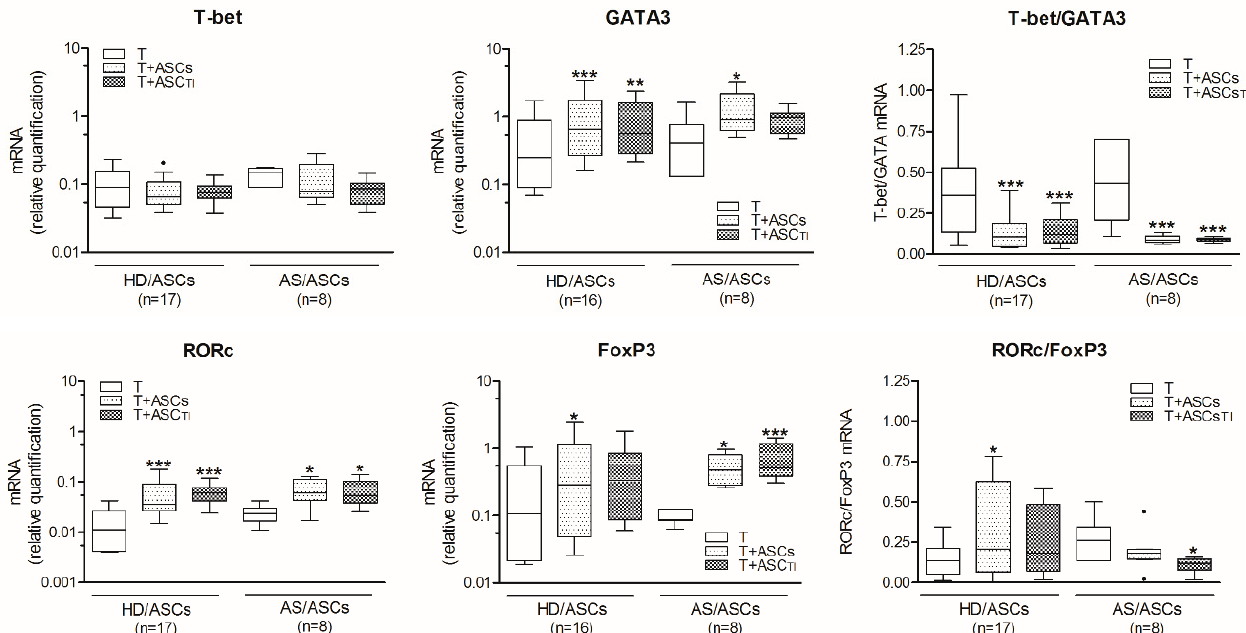
Figure 1. Direct effects of ASCs on the expression of Th subset specific transcription factors. T helper (CD3 + CD4 + ) lymphocytes (T) were isolated from peripheral blood of 17 healthy donors, activated via CD3/CD28 pathway and co- cultured for 5 days with either untreated or TNF + IFN γ (TI) pre-stimulated 5 ASCs lines of healthy donors (HD/ASCs) or 8 ASCs lines obtained from AS patients (AS/ASCs). The ASCs-T cell co-cultures were performed using a random combination of both cell types and the number of experiments is shown ( n ). The levels of expression of mRNAs coding for T-bet, GATA3, RORc, and FoxP3 transcription factors, specific for Th1, Th2, Th17, and Treg cell subsets, respectively, were assessed by quantitative RT-PCR, as described in the Materials and methods. Results are expressed as the median (horizontal line) with interquartile range (IQR, box), lower and upper whiskers (data within 3/2xIQR), and outliers (points/dots) (Tukey’s box). One-way analysis of variance (ANOVA) with repeated measures and post-hoc Tukey test was used to evaluate the effect of ASCs (T vs. T + ASCs or ASCsTI; * p < 0.05; ** p < 0.001; *** p < 0.0001). The inter-group (HD vs. AS) differences, evaluated by the Mann-Whitney test, were statistically insignificant.